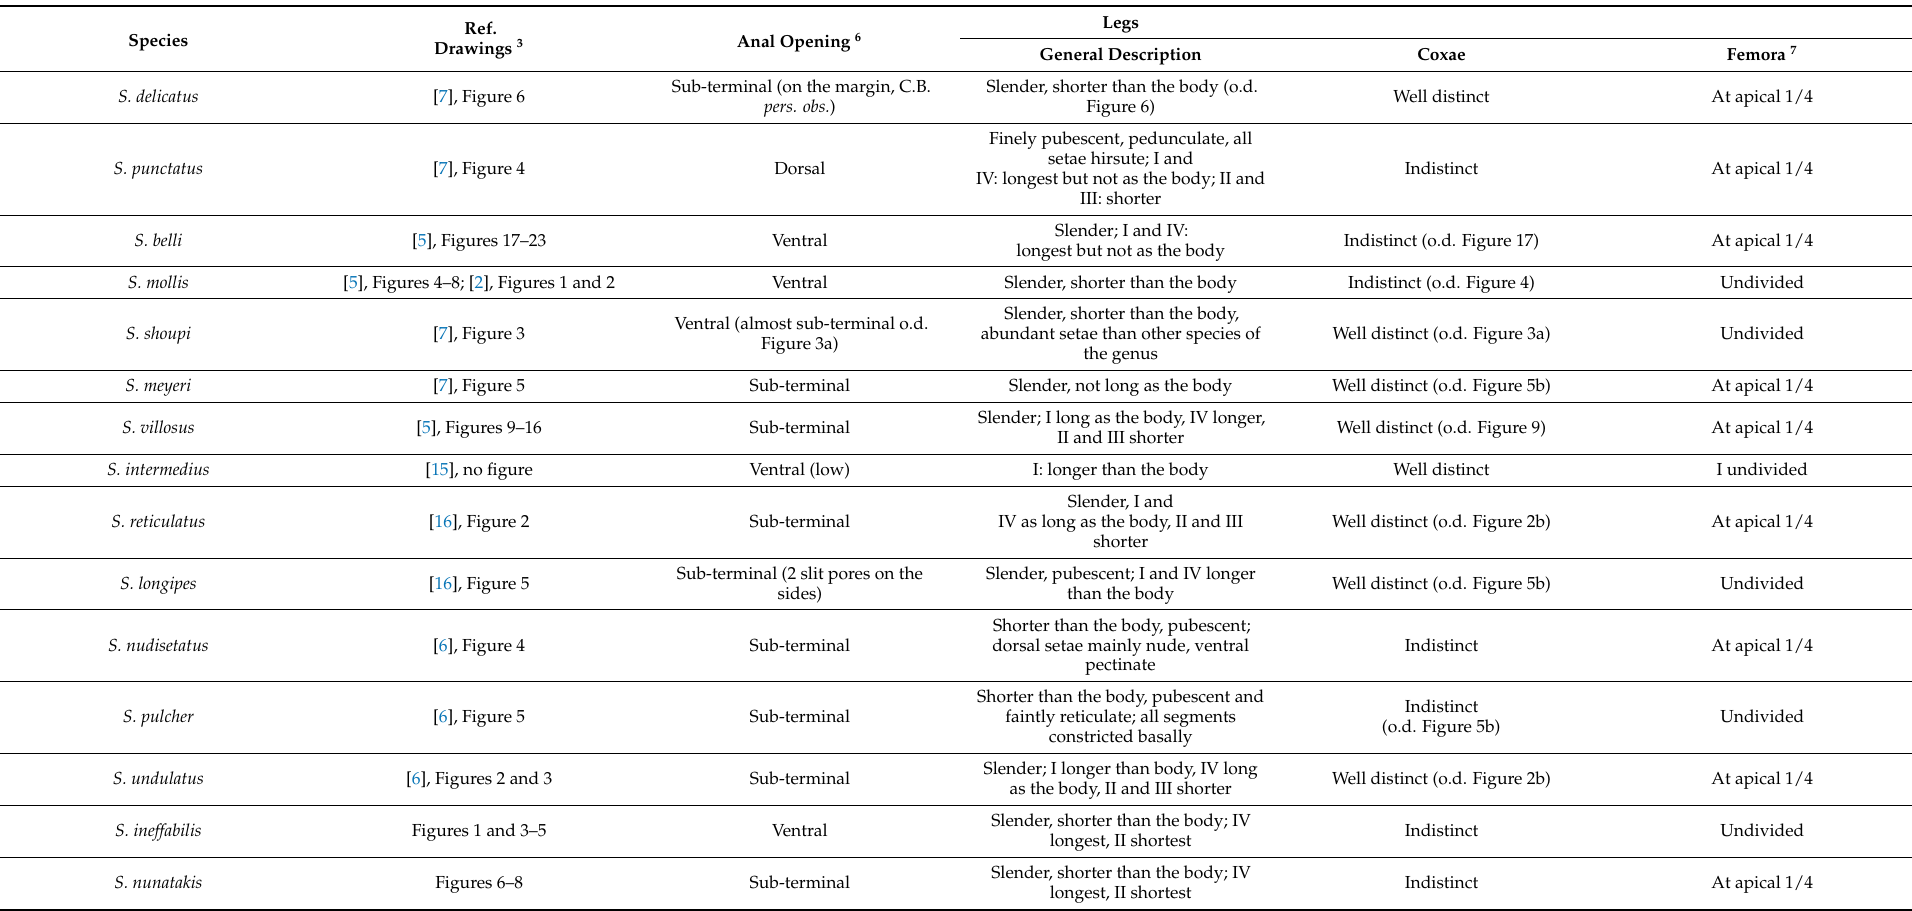
Table A5. Synoptic table of the Antarctic and sub-Antarctic Stereotydeus species with particular attention to the morphological characteristics useful for the identification of the different species. When a characteristic was not in the main text of the description, the reference drawings were used to extrapolate the data and mentioned in the table; on drawing (o.d.); personal observations ( pers. obs.